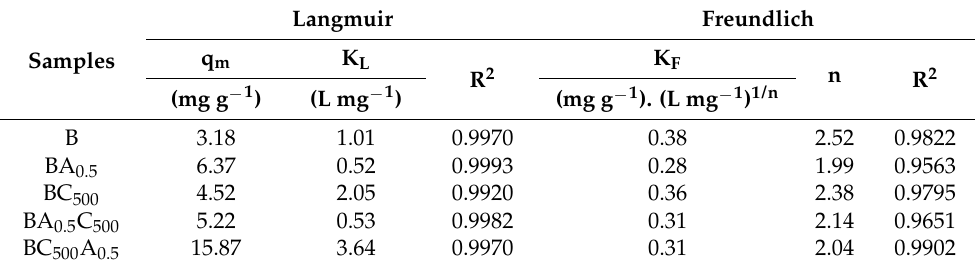
Table 7. Langmuir and Freundlich atrazine adsorption isotherm constants.